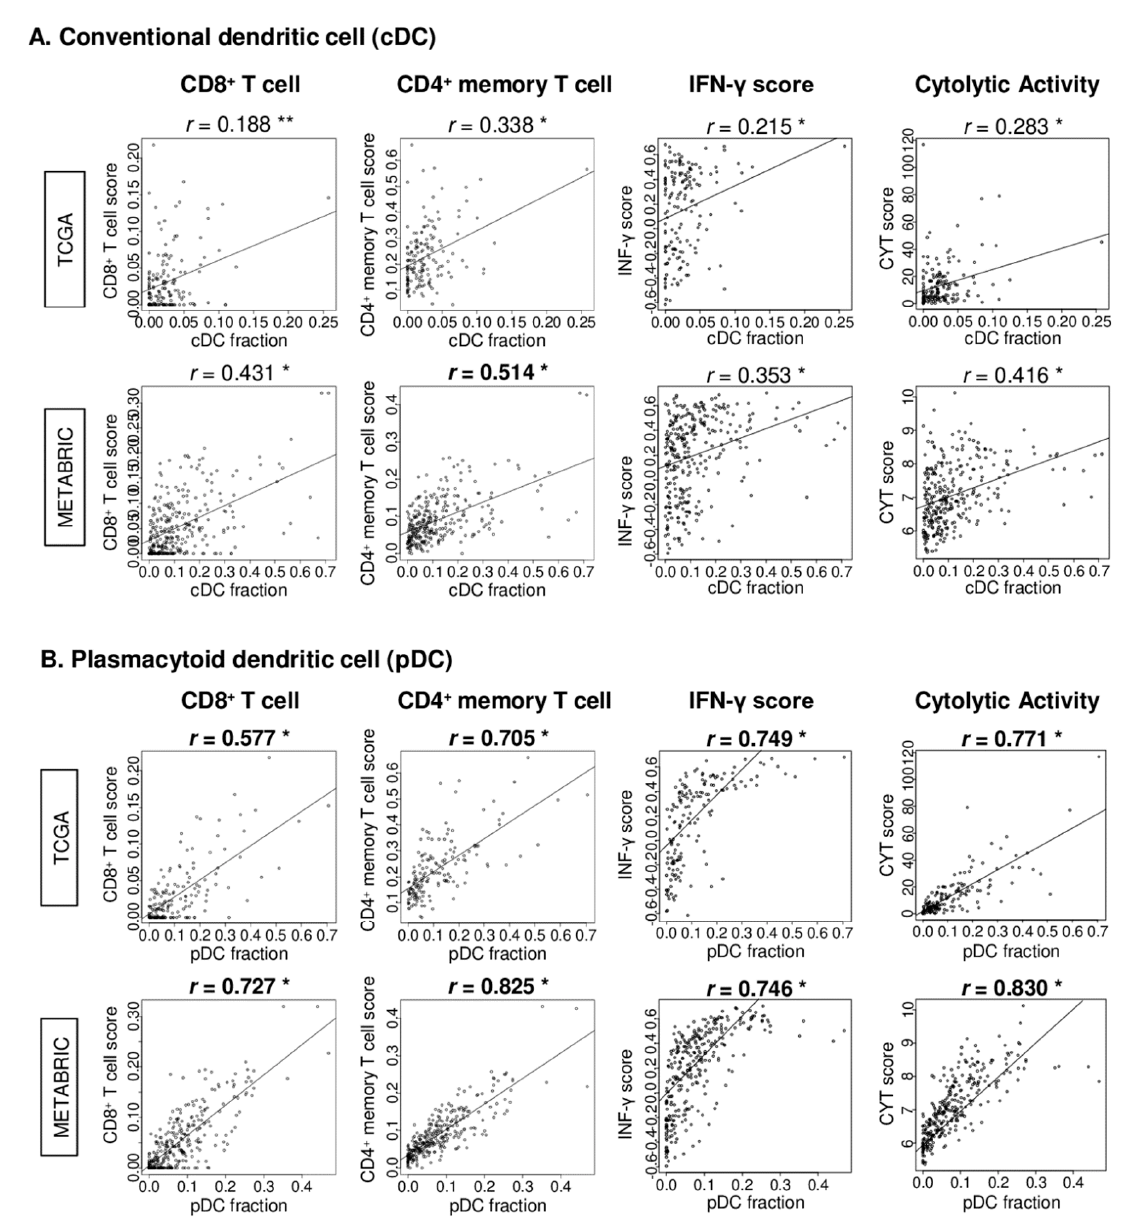
Figure 5. Correlation analysis of cDCs or pDCs in TNBC with CD8 + T cells, CD4 + memory T cells, IFN- γ pathway, and cytolytic activity score (CYT). Correlation plots of the ( A ) cDCs or ( B ) pDCs with CD8 + T cells, CD4 + memory T cells, IFN- γ pathway score, and CYT. p -value was analyzed with the Spearman r correlation. * p -value < 0.01, ** p -value = 0.002.